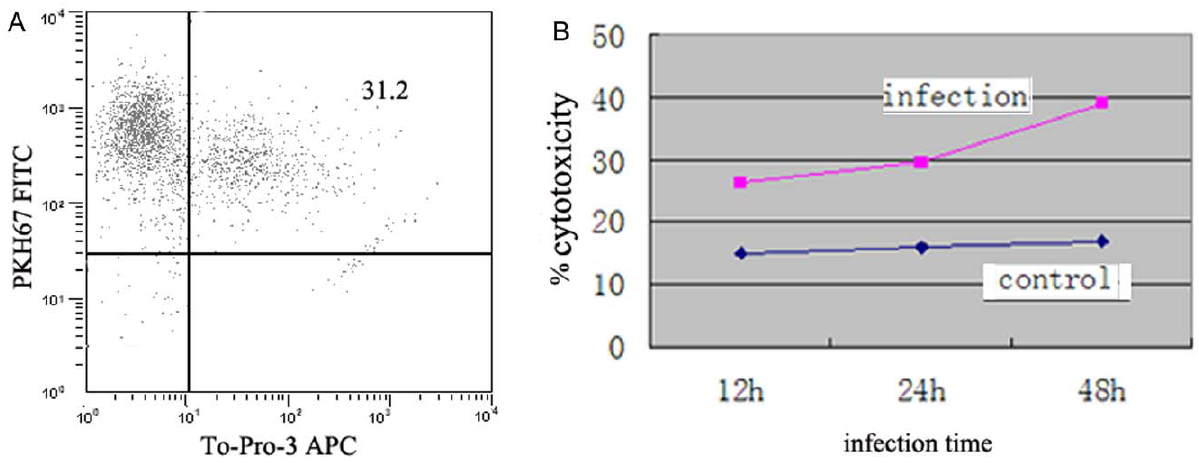
Figure 7. dNK cytotoxicity assays. The cytotoxicity caused by T. gondii was measure by co-staining uninfected and infected dNK cells with PKH67 and To-Pro-3 followed by flow cytometry analysis. (A) Total human extravillous trophoblast cells were stained with PKH67. Lysed cells are observed in the upper right frame. (B) Percentages of lysed human extravillous trophoblast cells in the presence of dNK cells incubated for 12 h, 24 h, or 48 h with T. gondii . Cytotoxicity of uninfected dNK cells was also determined. Data shown are averages of three independent